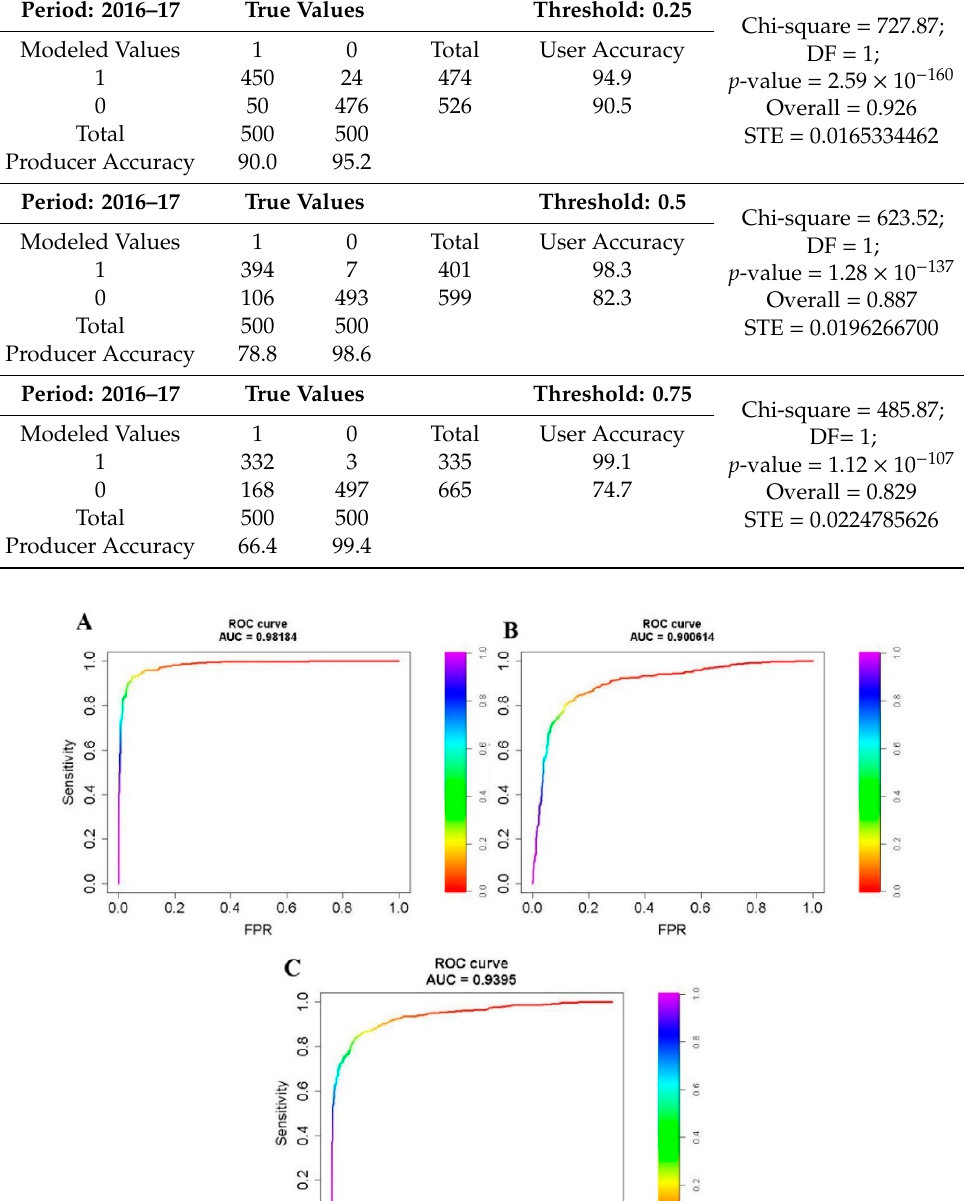
Table 4. Accuracy Assessment report for the period 2016–17, as estimated with the Raster Utility tools based on a validation dataset of 1000 random samples (50% in each class). Random Forests results were split into treatment and no treatment pixels based on three thresholds (0.25, 0.5 and 0.75).